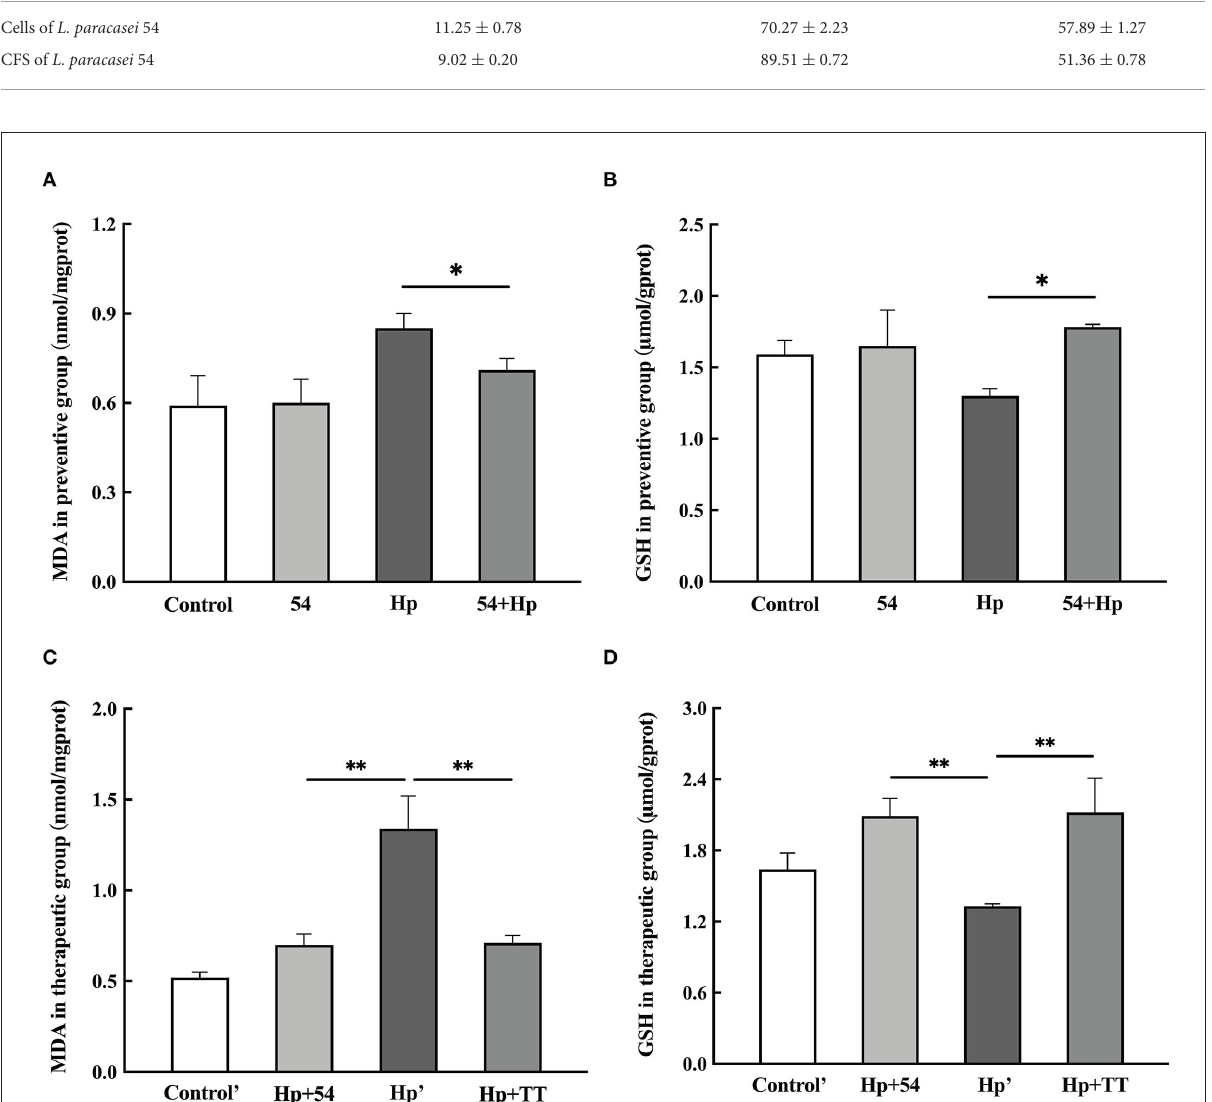
FIGURE4 Levels of MDA and GSH during prevention and therapy. (A) MDA levels in preventive groups. (B) GSH levels in preventive groups. (C) MDA levels in therapeutic groups. (D) GSH levels in therapeutic groups. Data are shown as the mean ± SD ( n = 6). Significant differences between two groups based on Student’s t -test, * p < 0.05, ** p <